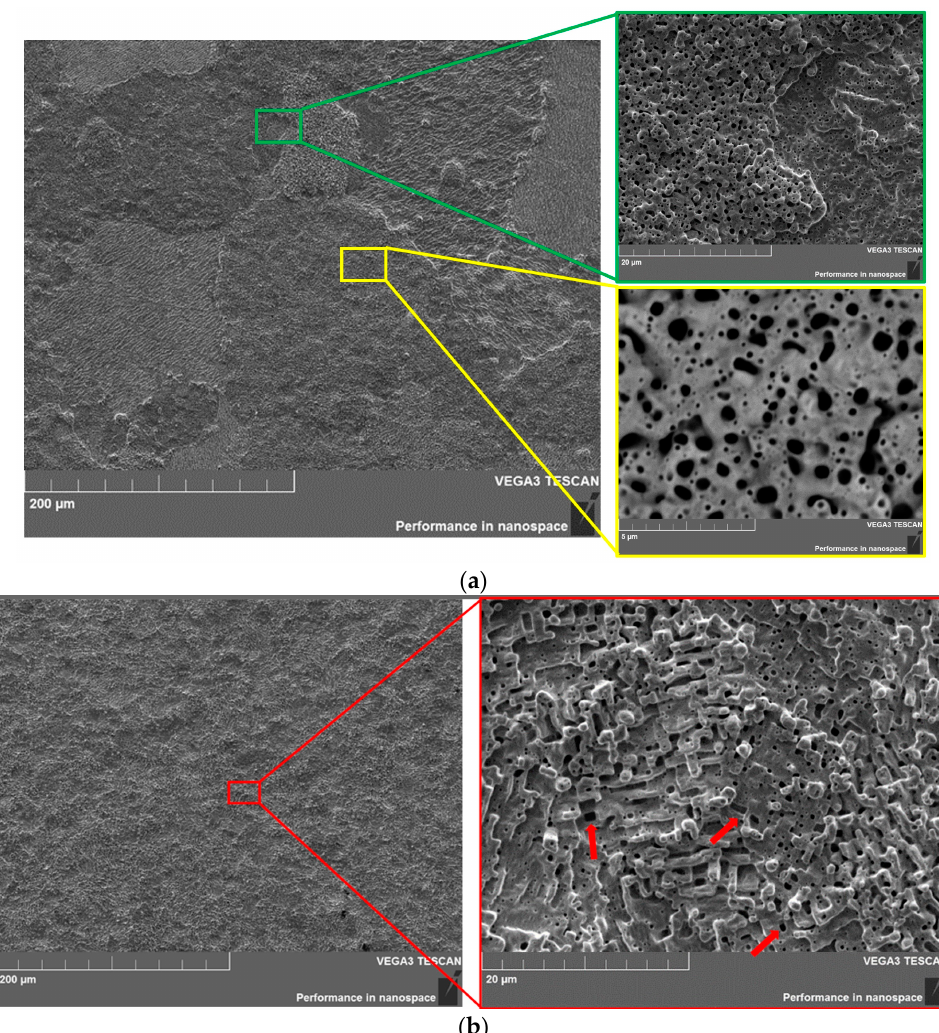
Figure 7. Microstructure of the surface of tungsten samples with a carbide layer based on the WC phase after irradiation with helium plasma at different temperatures (red arrows indicate large pores formed during irradiation). ( a ) Sample No. 3 ~905 ° С , ( b ) sample No. 4 ~1750 ° С .